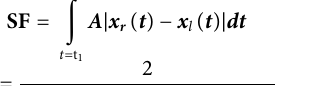
symmetry function. In addition, t 1 and t 2 stand for the time at heel strike and time at take-off, respectively. Formula 2 is an integrand and is referred to as the SF. The time-dependent information of symmetry at 101-time points in the action stage is re fl ected in the SF. The closer SF is to 0, the more symmetric the bilateral variables are de fi ned (Formula 3). This study set a ± 5% symmetry threshold to discriminate asymmetry areas (Winiarski et al.,